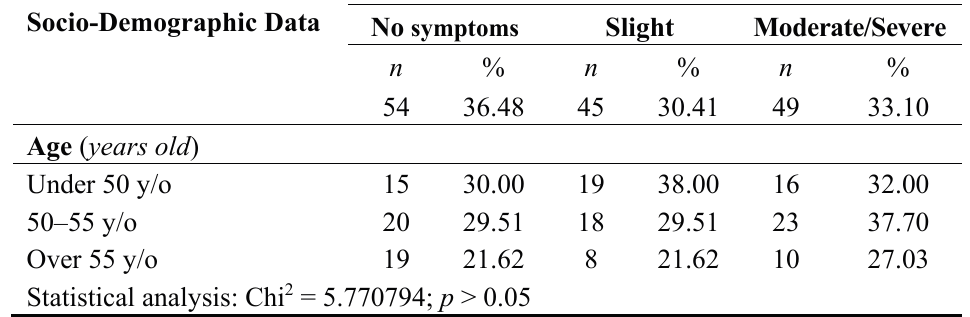
Table 2. Reported intensity of climacteric symptoms broken down by socio-demographic data (n =